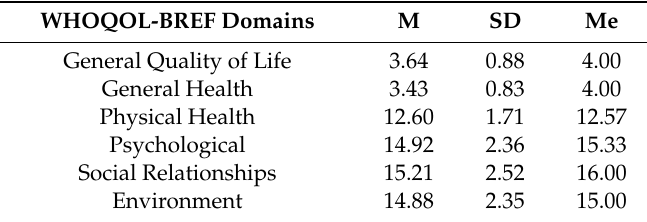
World Health Organization Quality of Life—BREF (WHOQOL-BREF) scores in the hyperglycemic pregnant women studied.